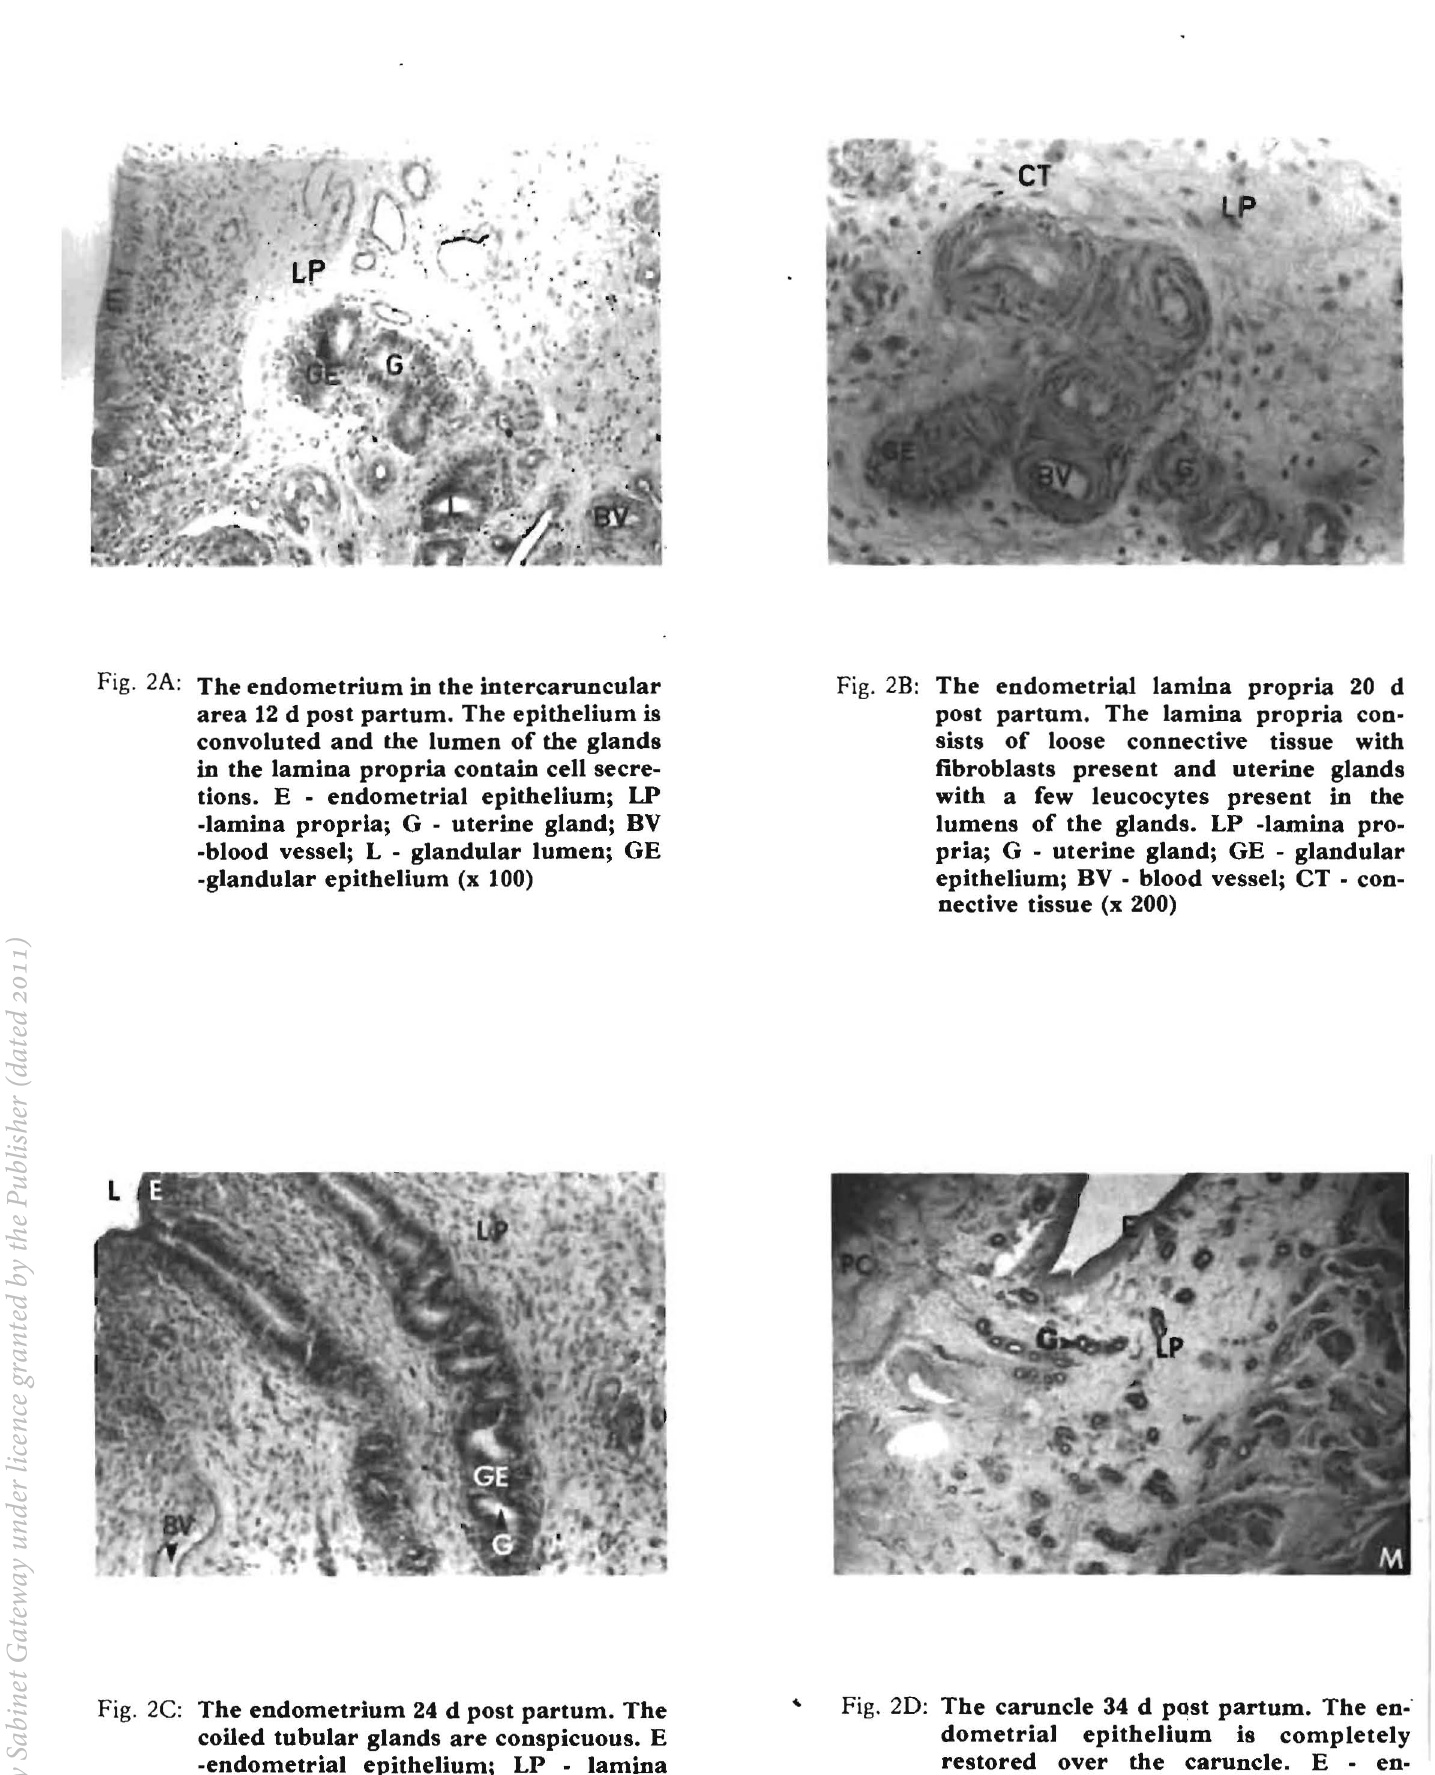
Fig. 2C: The endometrium 24 d post partum. The coiled tubular glands are conspicuous. E -endometrial epithelium; LP - lamina propria; GE -glandular epithelium; BV -blood vessel; L - uterine lumen (x 100) p e R